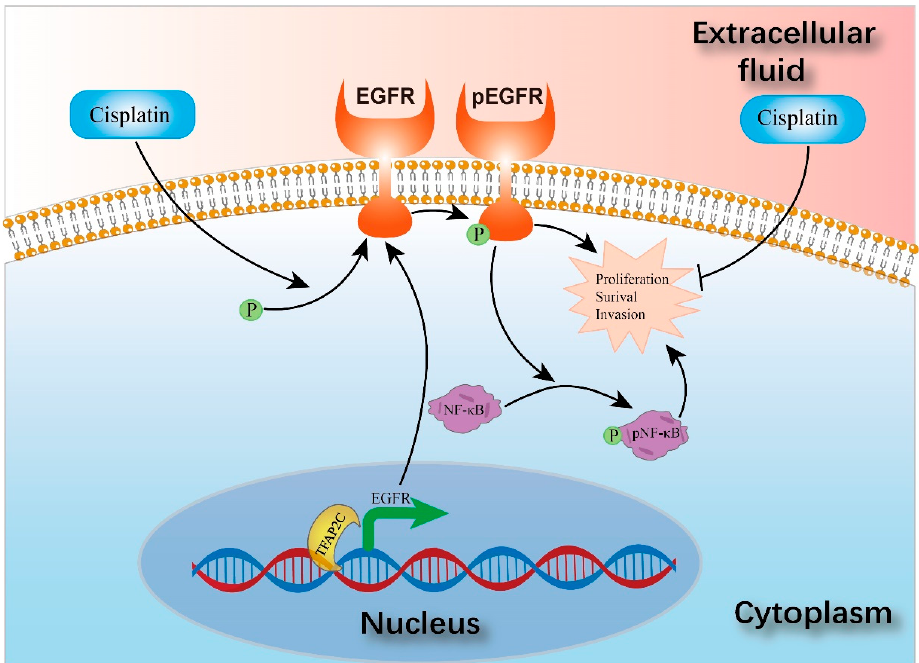
Figure 10. The ability of BCa cells to proliferate, survive, invade and migrate is impaired by cisplatin. However, the cells also activate cellular protective mechanisms by activating EGFR, which leads to depletion of EGFR; knockdown of TFAP2C further reduces EGFR, leading to a further decrease in its activation. In conclusion, TFAP2C is an important factor in maintaining EGFR levels in cisplatin- induced EGFR